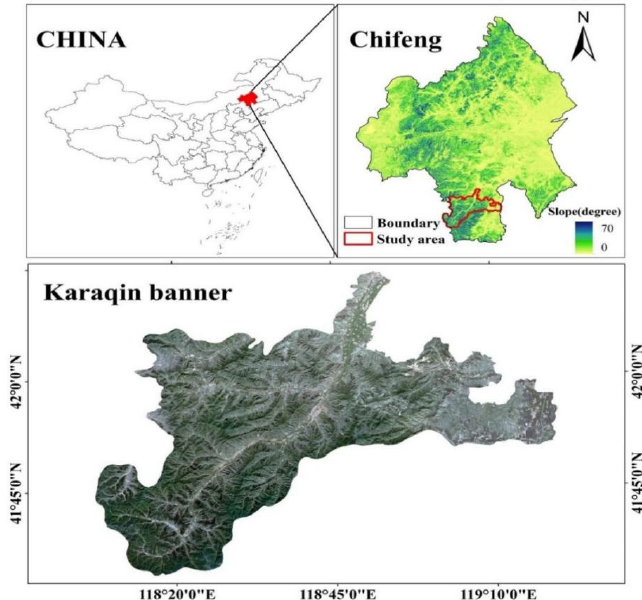
Figure 1. Location of the study area.